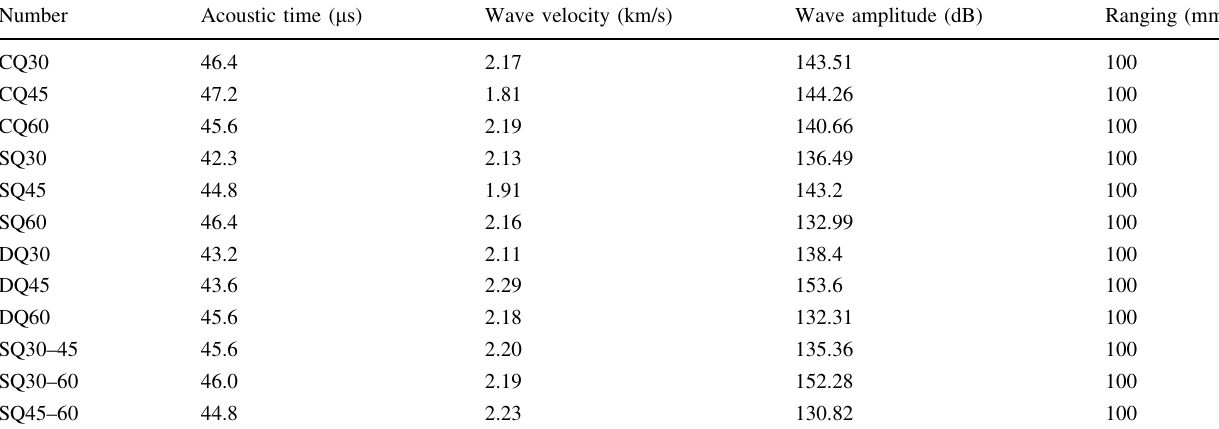
Table 5 Acoustic parameters of the test block after uniaxial compression